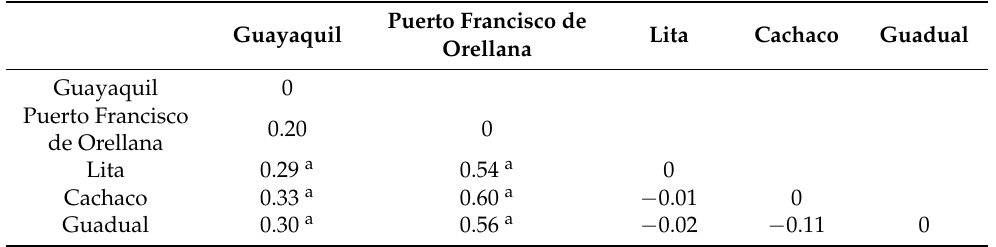
Figure 4. Bayesian 50% rule consensus tree for Aedes albopictus using the COI gene. Posterior probabilities are shown above the branches, and bootstrap support values for the ML tree are shown below the branches. Table 2. FST values for individuals from five populations of Aedes albopictus from Ecuador. p -value a p <